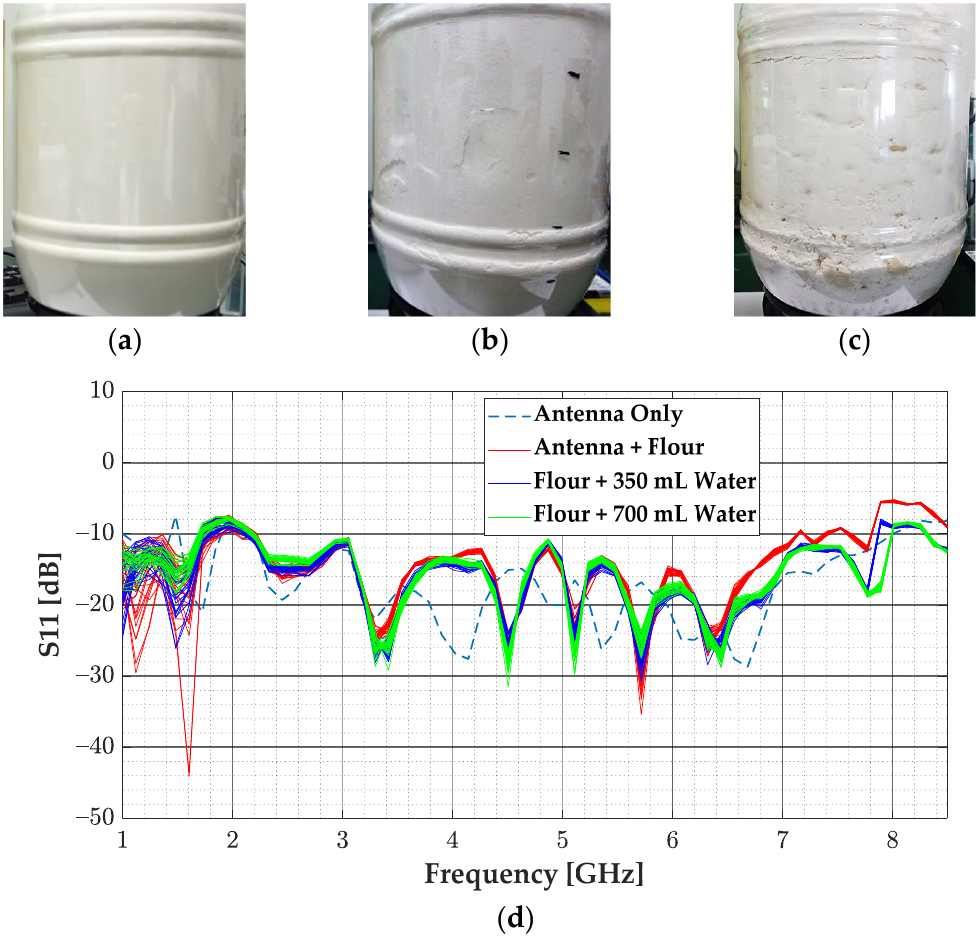
Figure 14. Inhomogeneous medium after adding water to the background: ( a ) flour only, ( b ) flour